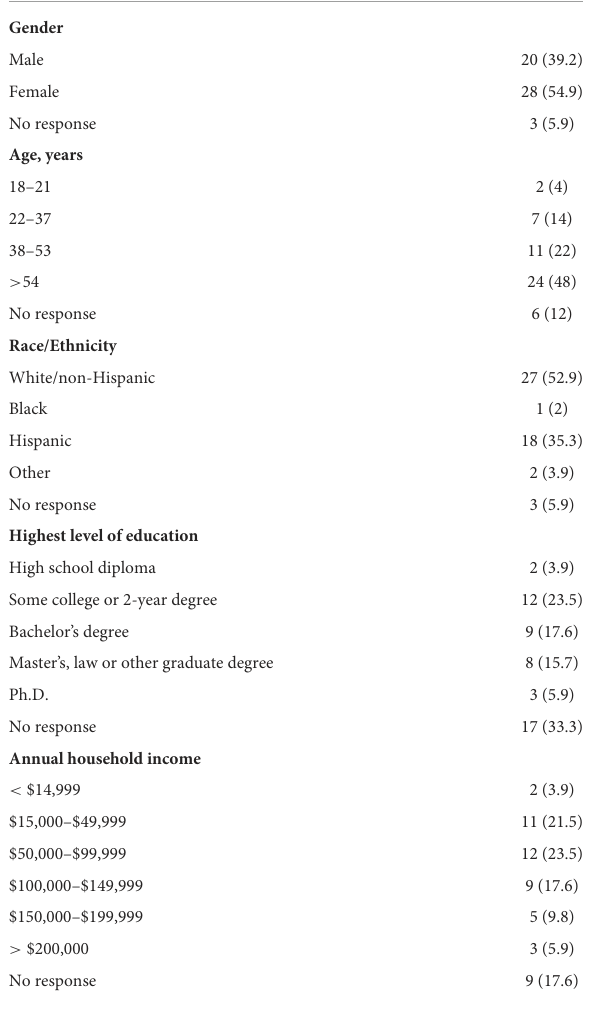
TABLE 3 Demographic characteristics of